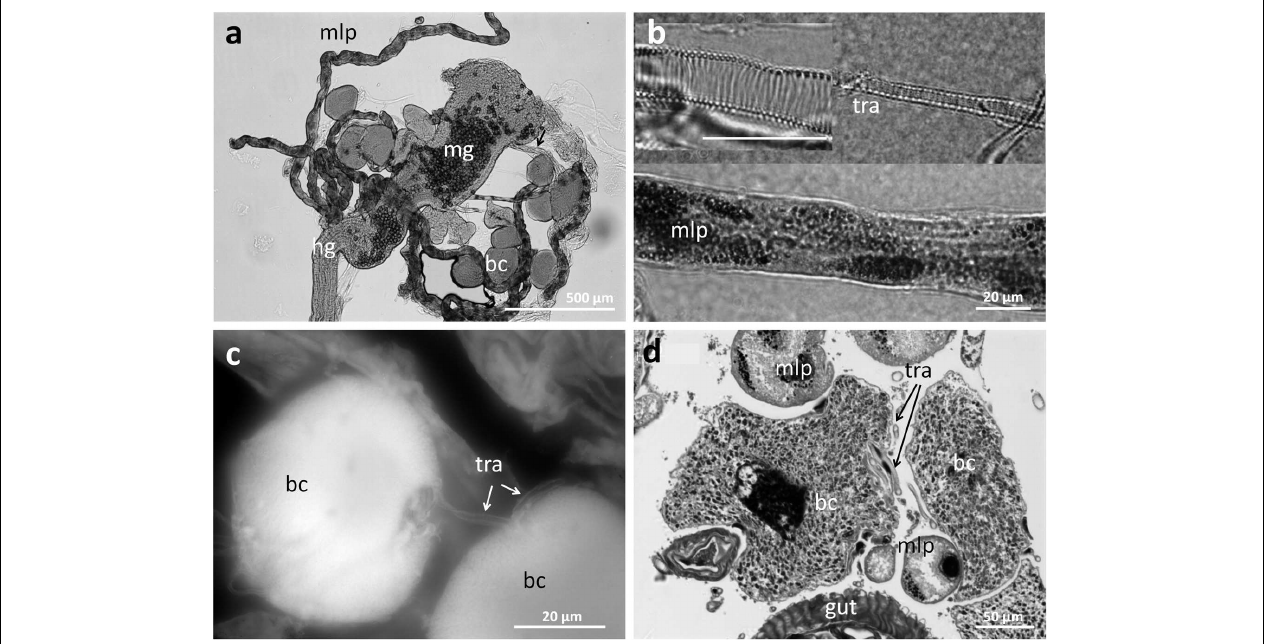
FIGURE 5 | Structure of the bacteriomes in Dasytes and their connection to the respiratory system. (a) Bacteriomes localized at the junction of mid- and hind-gut. Note the pollen grains in the mid-gut. (b) Close-up images of trachea and Malpigian tubule closely associated with the bacteriome. (c) Close association of two bacteriocytes with a trachea. Image created based on Cy3 autofluorescence. (d) Cross section of a bacteriome in Dasytes plumbeus, with the densely packed intracellular symbionts clearly visible. Note the close association with Malpighian tubules and tracheae. Abbreviations: mg, mid-gut; mlp, Malpighian tubules; hg, hind-gut; bc, bacteriocytes; tra,